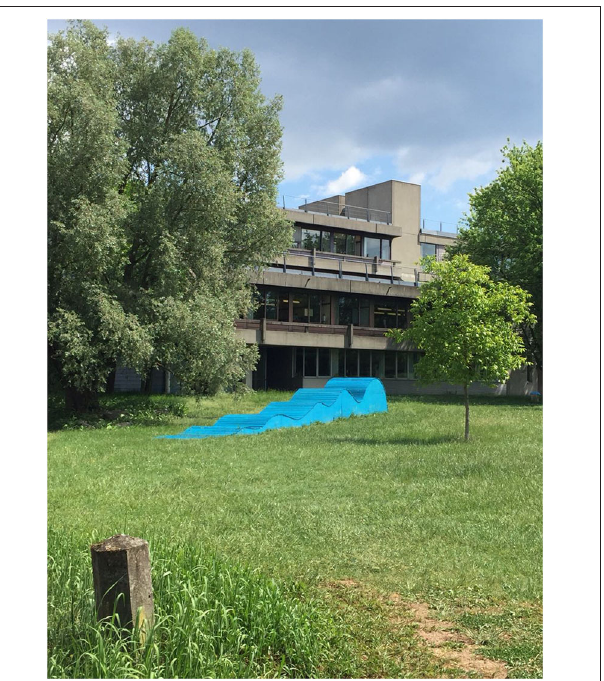
FIGURE 5 | Students tend to sit or lie down on the lawn during their breaks, as there is no facility encouraging them to move (Photo: U2